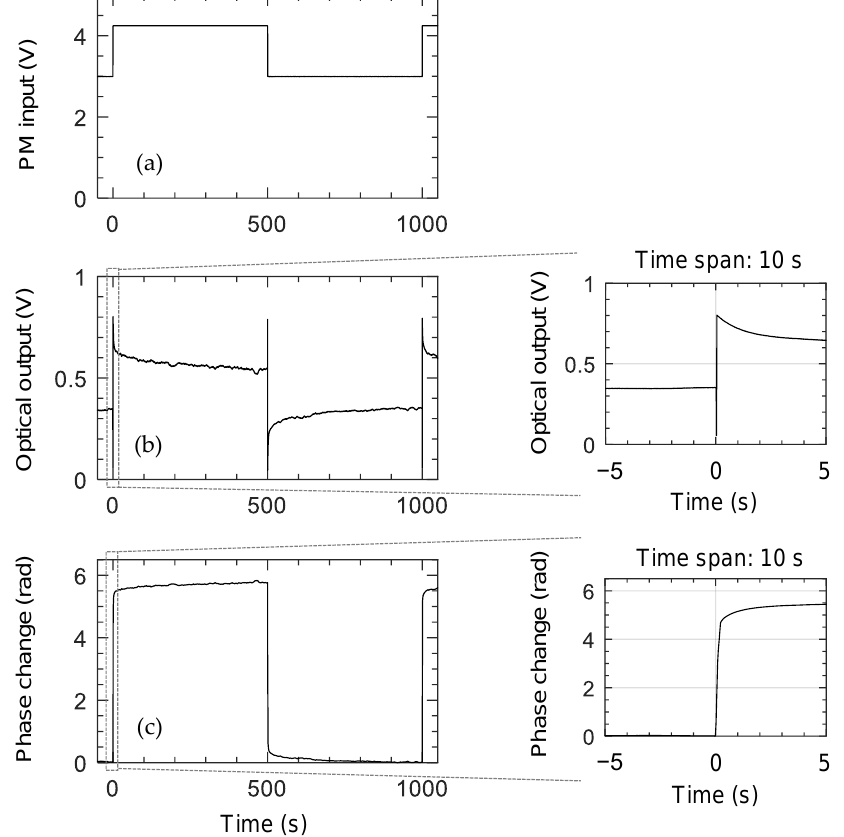
During the small-signal response measurement, especially for a low-frequency signal less